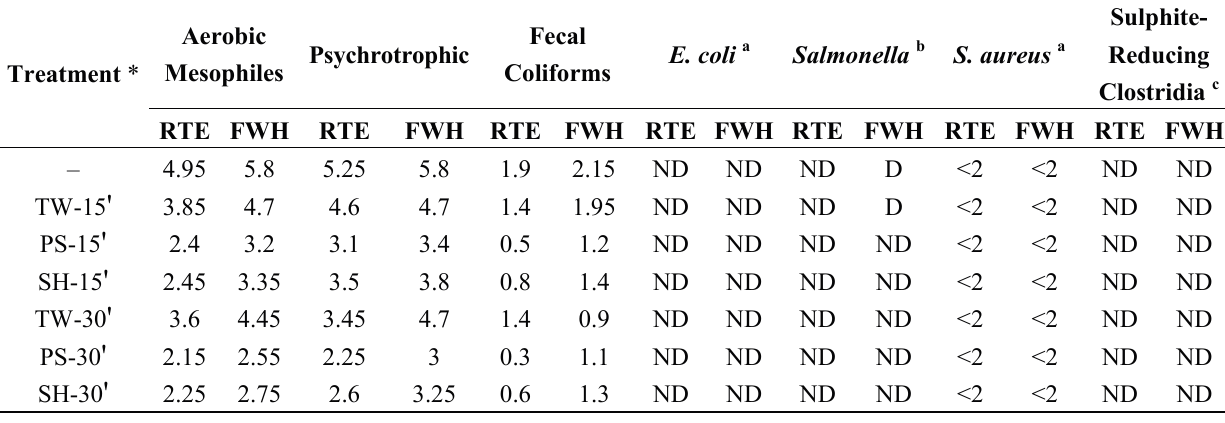
CFU/g) of the microbiological analysis made to the ready-to-eat Table 3. Results (log 10 (RTE) and fresh whole head (FWH) lettuce submitted to different sanitization